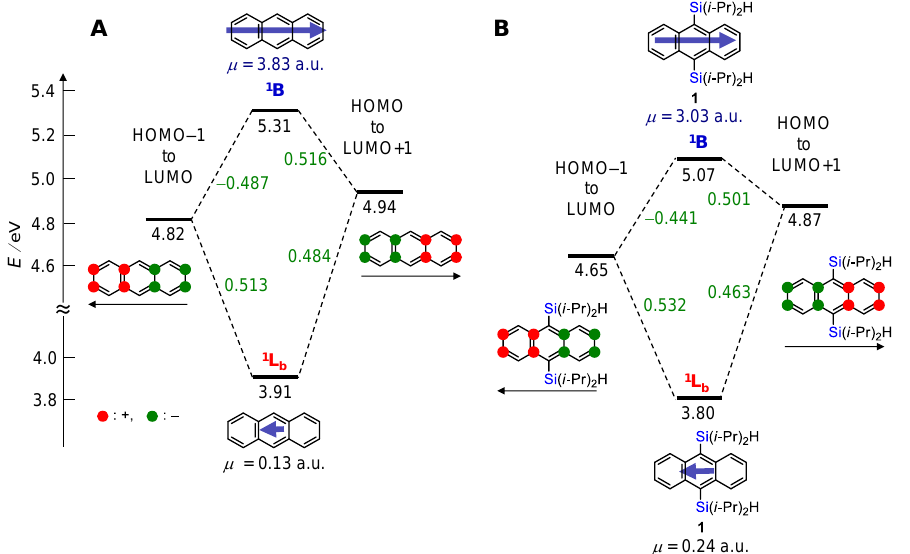
Figure 5. Configuration interaction between transitions for the 1 B and 1 L b bands of 1 ( B ) and anthracene ( A ) calculated at the TD-DFT B3LYP/6-31G(d) level. Energy levels were calculated at the B3LYP/6-31G(d) level. The structures with positive and negative circles show the products of orbital pairs representing the transition. The arrows under the structures denote transition moments.